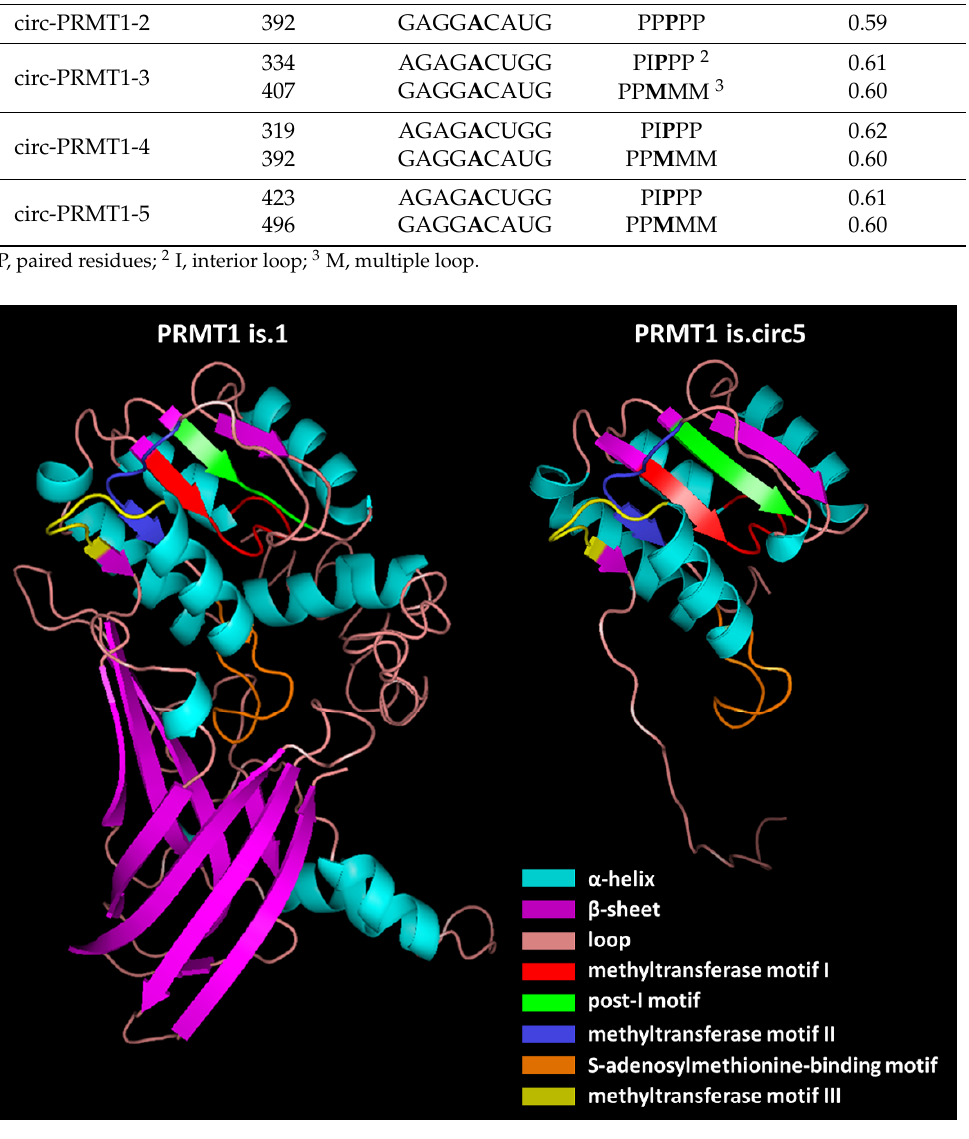
Figure 6. Predicted models of the main PRMT1 isoform (NP_001527.3) and the novel PRMT1 isoform that is potentially produced from circ-PRMT1-5, visualized with PyMOL. The I-TASSER server was used for the prediction, and only the 3D structure with the highest confidence score is displayed for both cases. The color code for the secondary structures and the shared main domains between the isoforms is also displayed.